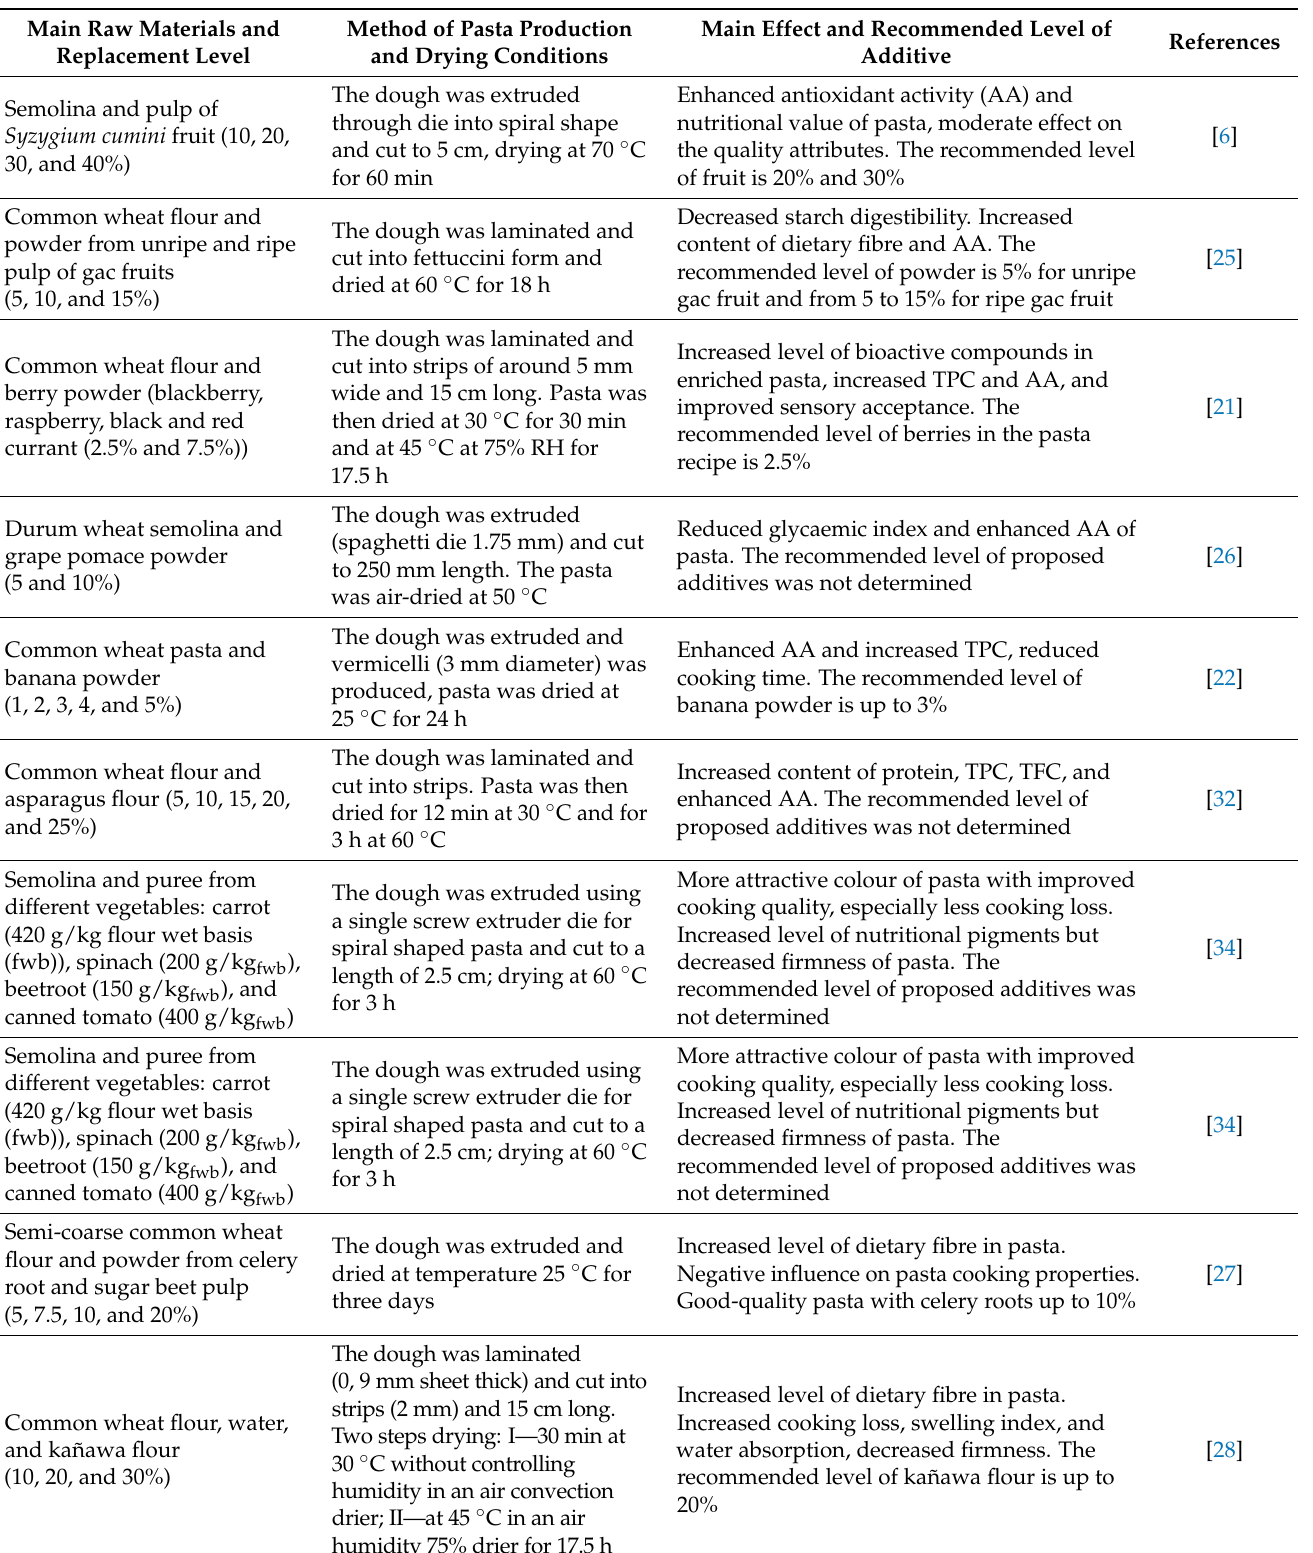
Table 1. Effect of wheat pasta fortification with fruits and